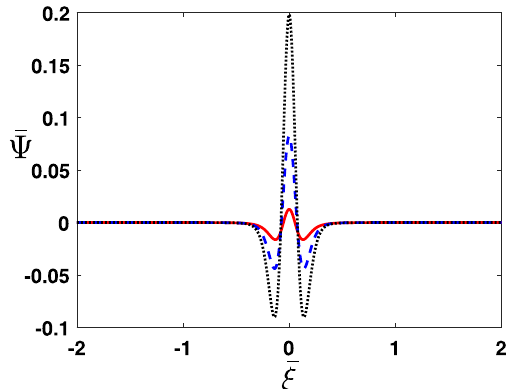
τ =0.1 (solid curve), ¯